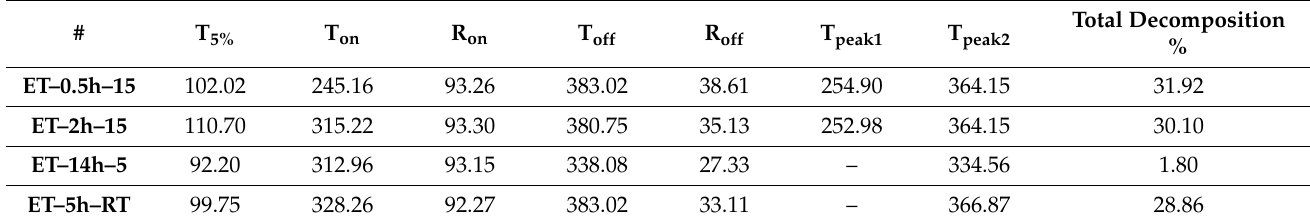
Figure 1. Typical images of the coated cotton fabric. Table 1. Thermogravimetric analysis parameters of the coated samples.